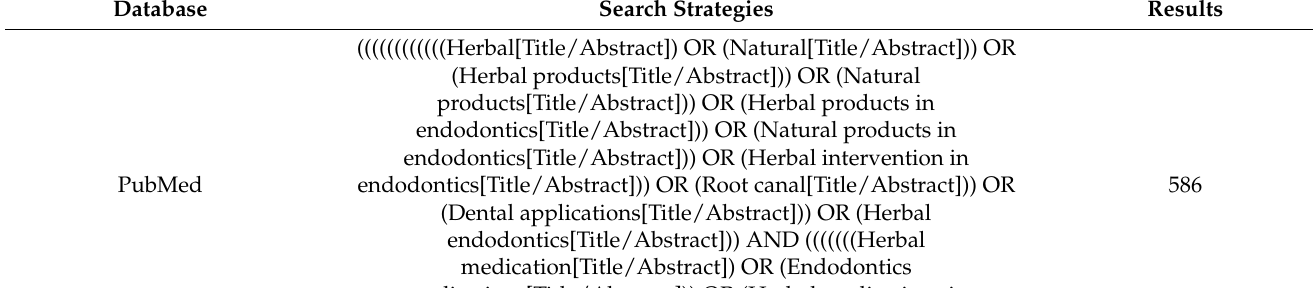
Table 1. Information of sources and Search strategies using MeSH keywords.